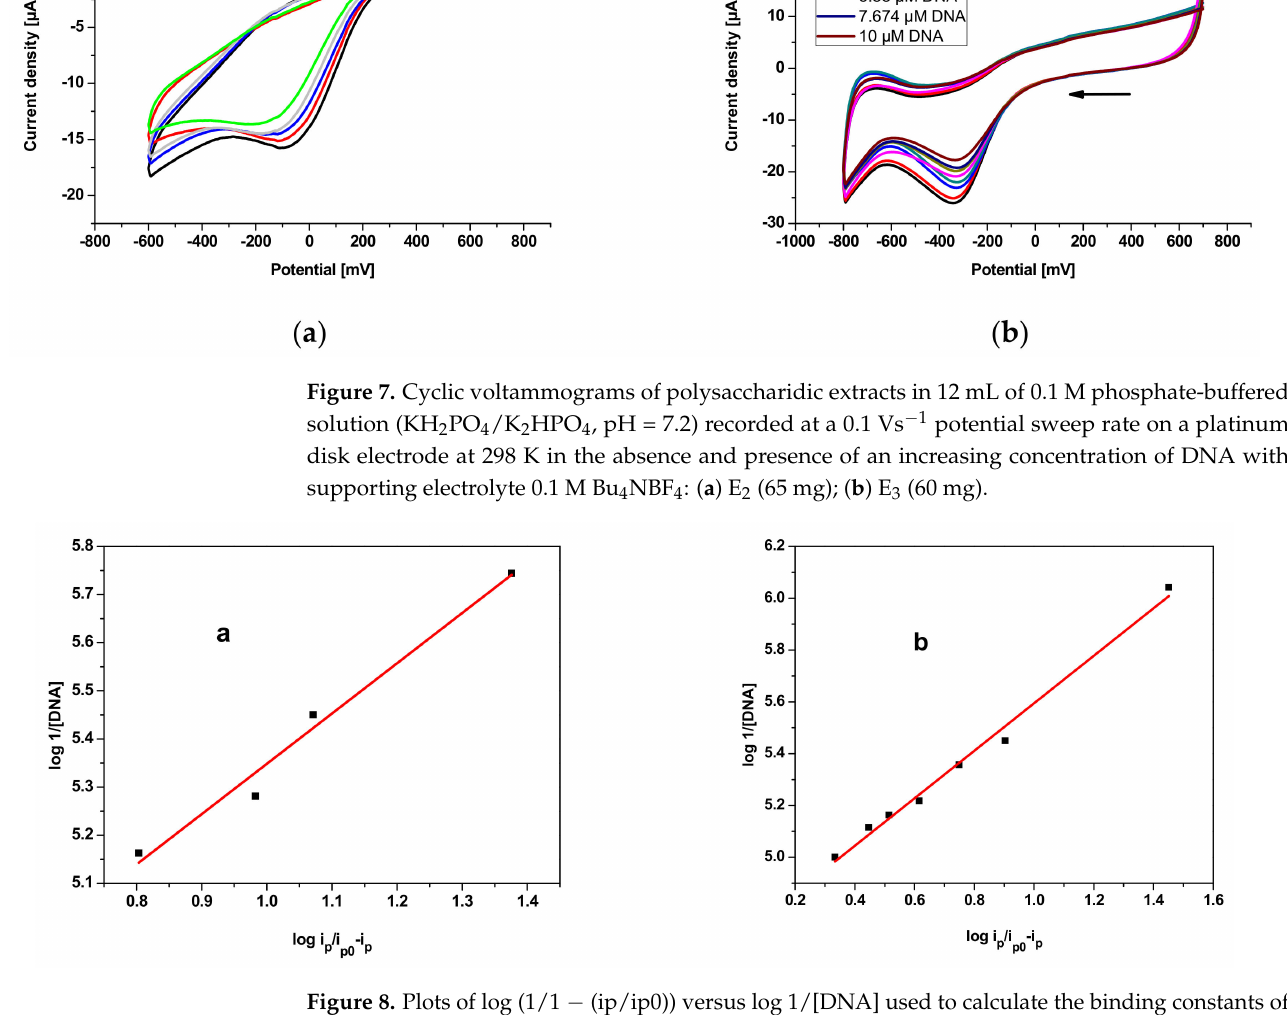
Figure 8. Plots of log (1/1 − (ip/ip0)) versus log 1/[DNA] used to calculate the binding constants of the E 2 and E 3 samples with DNA: ( a ) E 2 ; ( b ) E 3 .